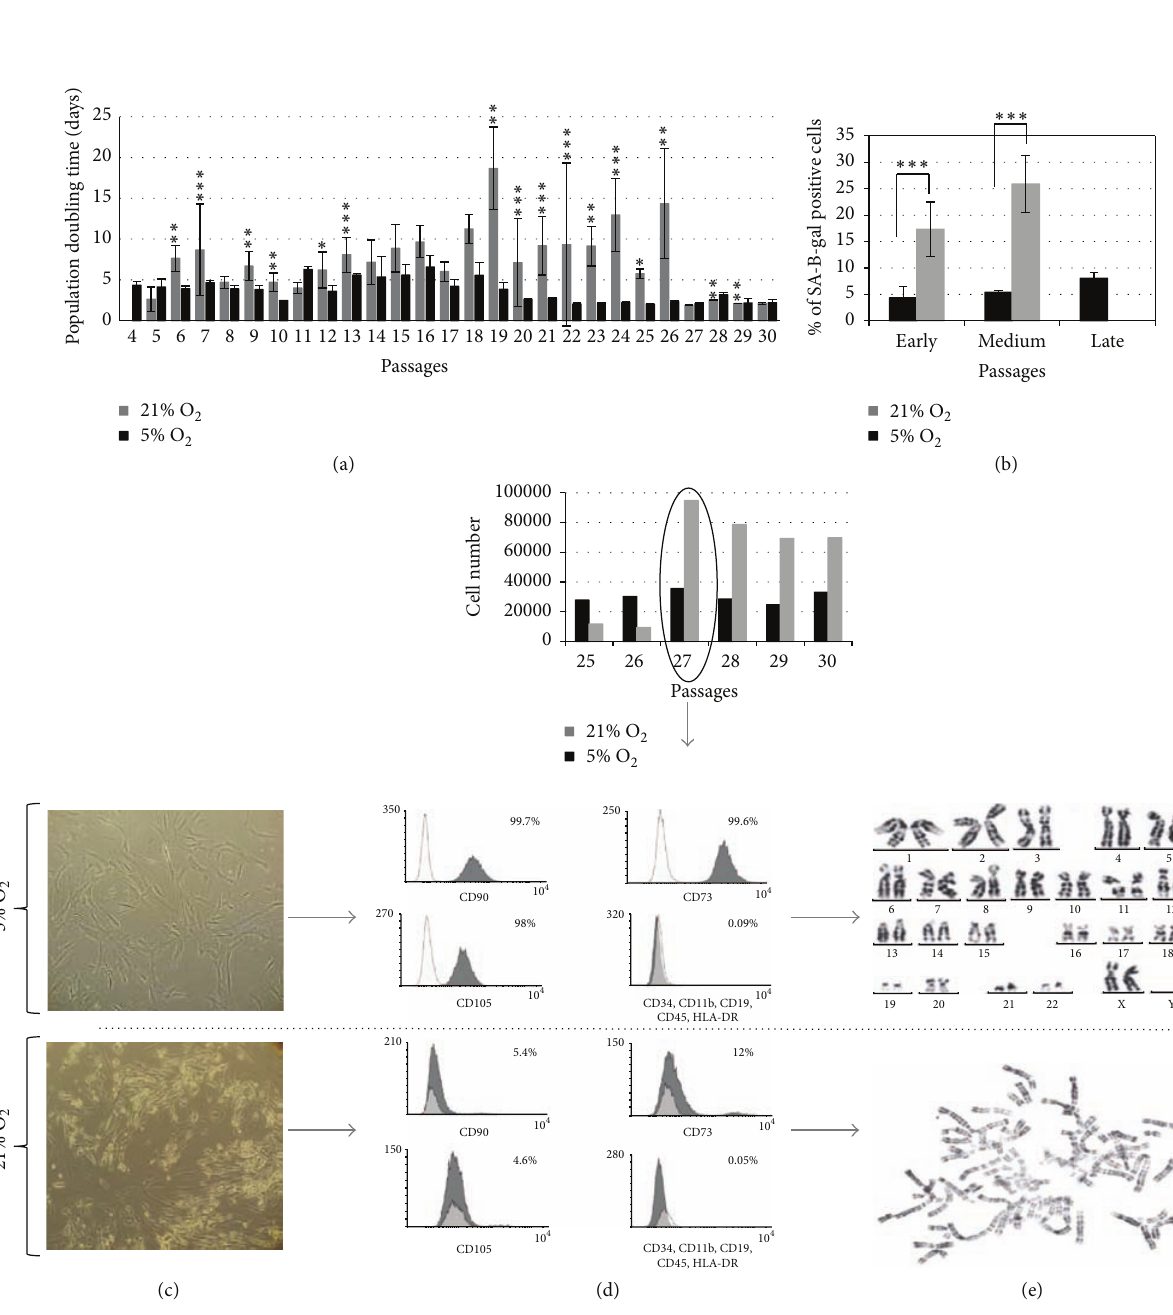
Figure 4: (a) The influence of physioxic 5% O 2 or normoxic 21% O 2 atmosphere on the quality of mesenchymal stem cell populations. AD- MSC cultured in 5% O 2 retain relatively stable proliferation rate, when AD-MSC culture in 21% O 2 atmosphere retain unstable, oscillating growth rate with the estimated population doubling time apparently falling down and rising again successively. (b) Percentage of senescent cells. In 21% O 2 atmosphere the increased number of SA- 𝛽 gal expressing cells was observed relative to cells cultured in 5% O 2 atmosphere. (c) The morphology of AD-MSC in physioxic and normoxic conditions. Whereas in the physioxic conditions AD-MSC retained spindle-shaped morphology during the whole estimated period, in normoxic conditions they firstly acquired typical feature of aging cells and then their phenotype changed. (d) Flow cytometry analysis. After long-term culture in 21% O 2 atmosphere we have noticed disturbed expression of MSC-specific surface antigen pattern, including complete lack of CD90, CD105, and CD73. AD-MSC growing in 5% O 2 by the same number of passages still presented correct CD90, CD105, and CD73 antigens pattern with typical lack of hematopoietic markers, CD34, CD11B, CD19, CD45, and HLA-DR expression. (e) The comparative chromosome analysis of AD-MSC cultures growing 28 passages in either 5% O 2 or 21% oxygen atmospheres. The cells growing in the physioxic conditions demonstrated proper karyotypes, whereas AD-MSC cultured in the air environment displayed severe karyotyping abnormalities, such as polyploidy of chromosomes (20 in 30 analyzed metaphases) and haploid chromosome numbers (10 in 30 analyzed metaphases); ∗ 𝑝 < 0.05 ; ∗∗ 𝑝 < 0.01 ; ∗∗∗ 𝑝 < 0.001